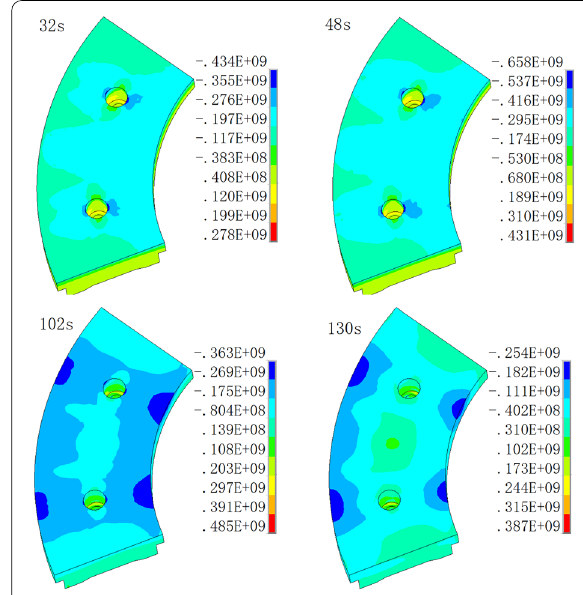
Figure 10 Circumferential stress contour of brake disc